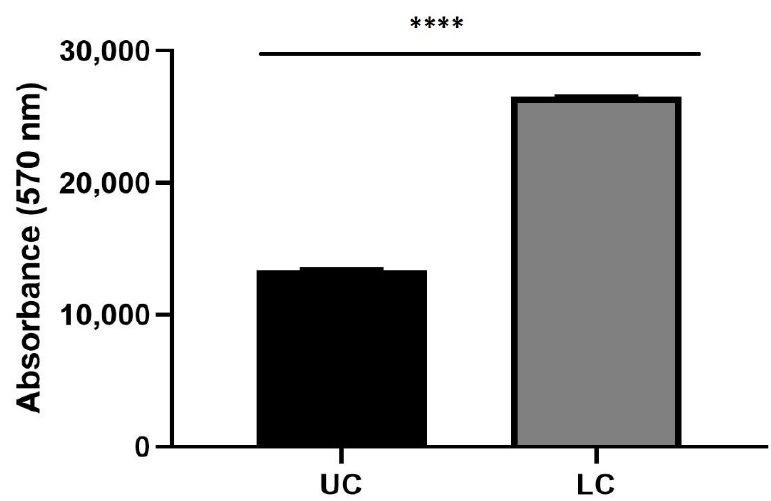
Figure 10. Spectrofluorometric analysis of rhodaminated PACAP (gH625-lipoPACAP-Rho) delivery across BBB dynamic in vitro model (LB2) with bEnd.3 in the upper chamber and 3D SH- SY5Y/RA/MPP + in the lower chamber. Functionalized liposome was loaded with PACAP-Rho and injected in the upper flow. The passage beyond the endothelial cell layer was then evaluated by sampling downstream the upper chamber (UC) and the lower chamber (LC), respectively. The graph shows the means ± SEM of three experiments. Statistical analysis was performed through the analysis of Mann–Whitney test. The differences were considered significant between gH625-lipoPACAP-Rho UC and gH625-lipoPACAP-Rho LC. **** p <